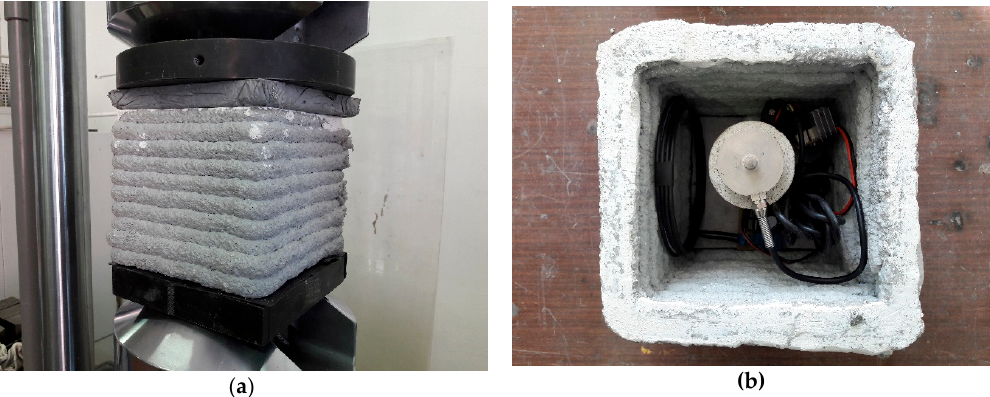
Figure 17. Concrete sensing element: ( a ) the device under test, ( b ) open element showing the enclosed system.